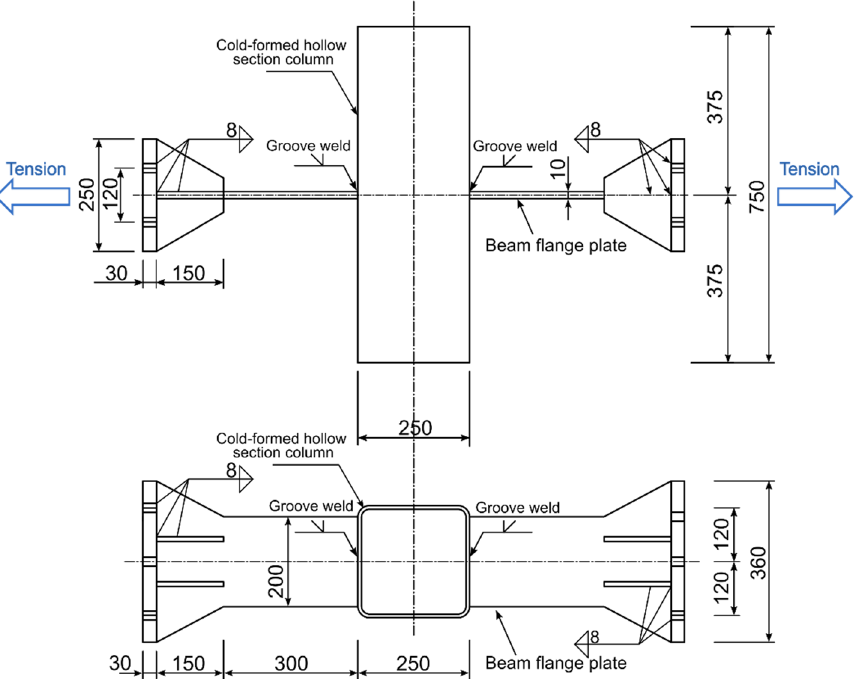
Table 4. Material property at each region RP-1 specimen [26,37].